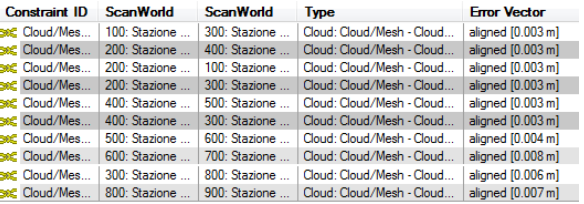
Figure 6. Results of the registration refinement.